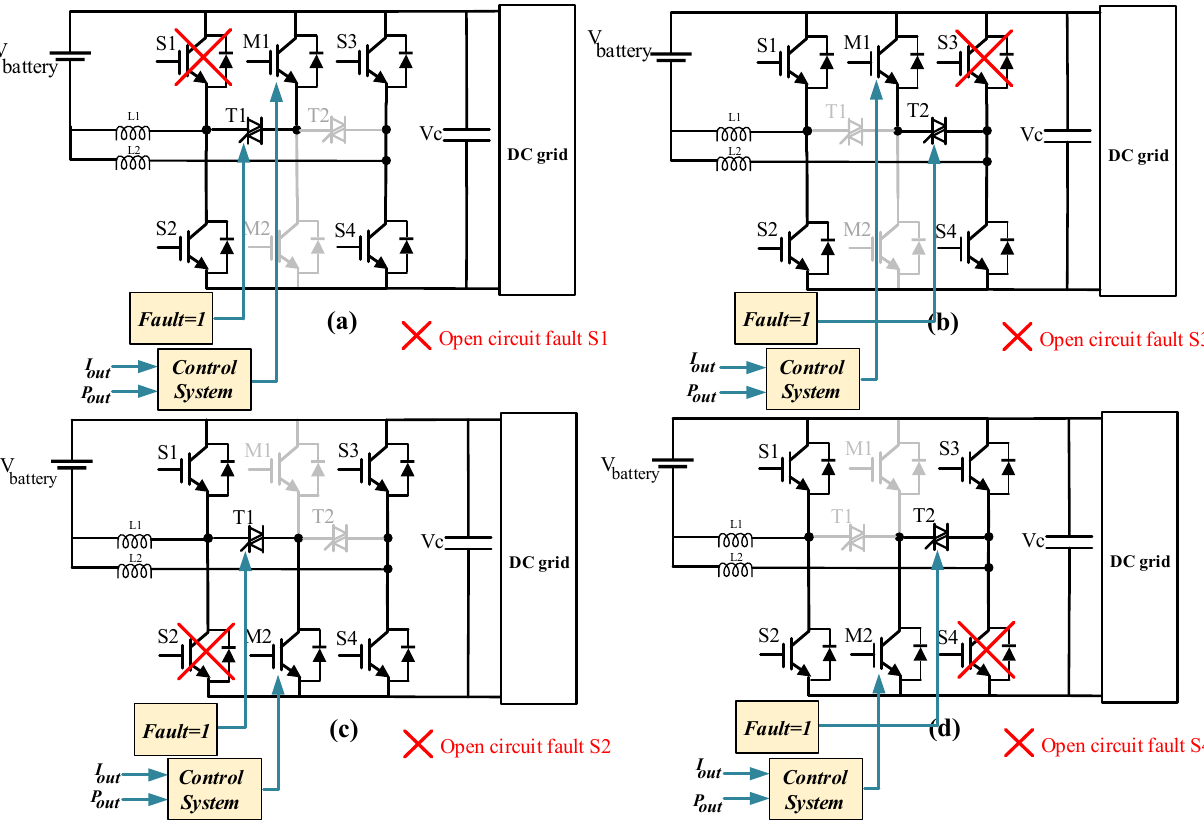
Figure 6. Reconfigured fault–tolerant converter for an OCF ( a ) on power switch S1; ( b ) on power switch S3; ( c ) on power switch S2; ( d ) on power switch S4 .